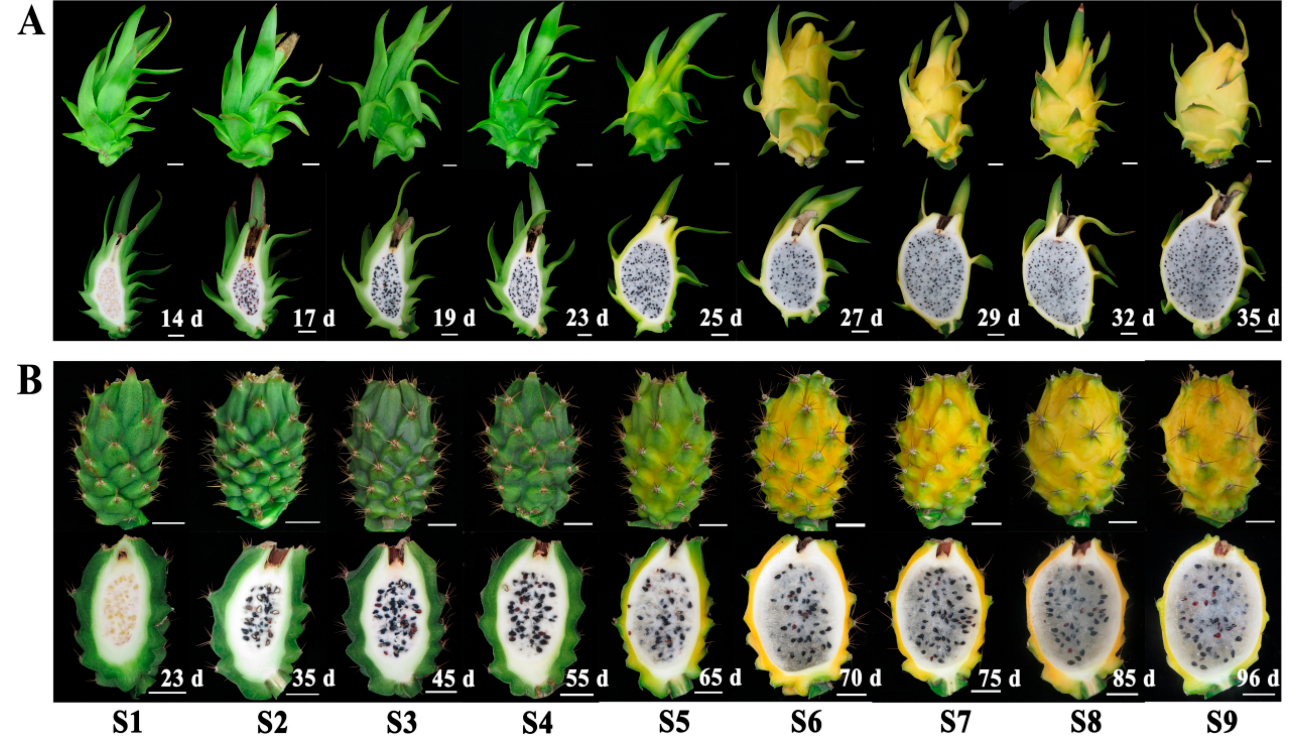
Figure 1. Photograph of ‘WCHL’ ( A ) and ‘YCHL’ ( B ) pitayas at nine (S1–S9) developmental stages.